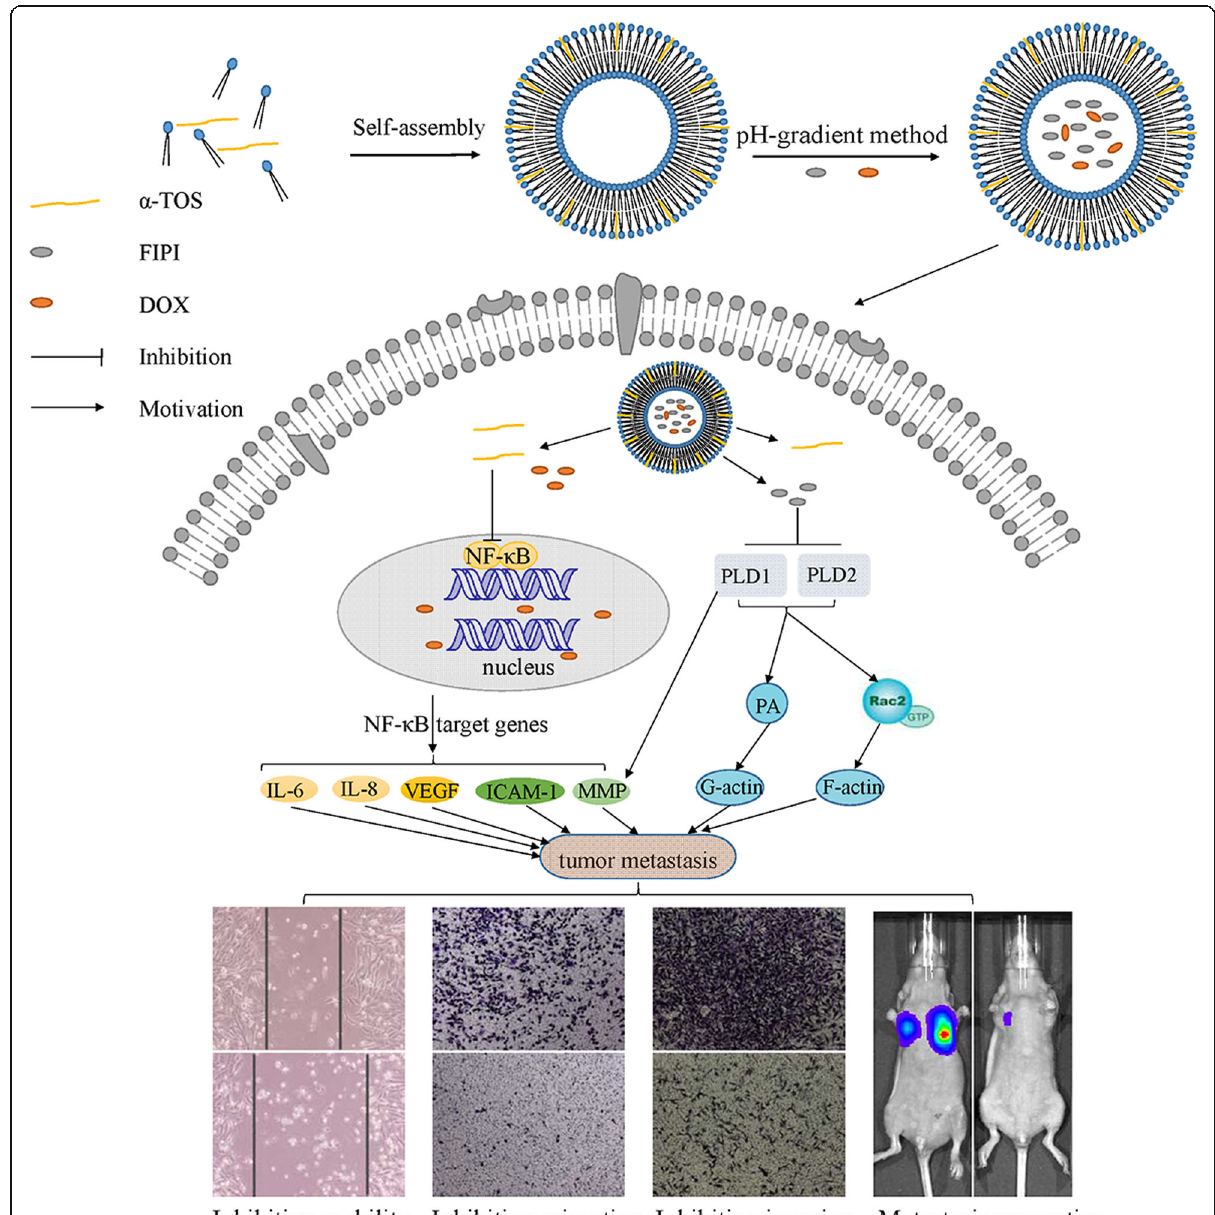
Fig. 8 Schematic diagram of action mechanism for